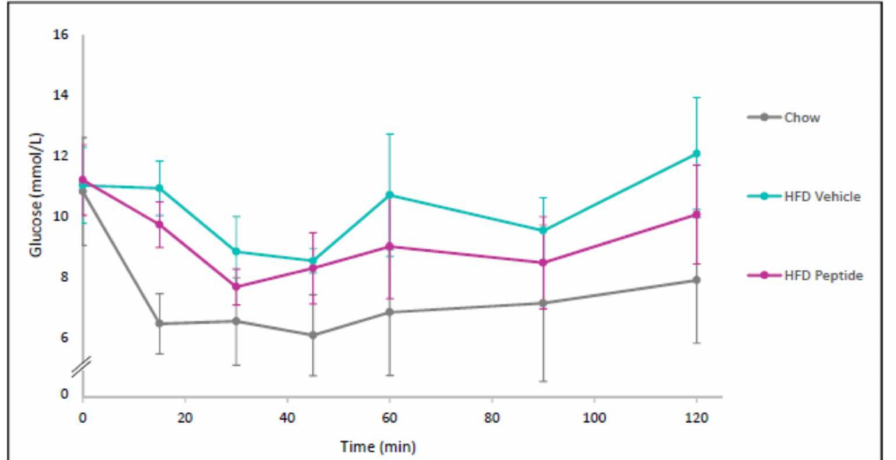
Figure 10. The TNFSF14 Peptide 7 reduces high fat diet-induced insulin resistance. Mice were placed on a chow or a high fat diet (HFD) ( n = 4–5 mice/group). The HFD was administered for 10 weeks before Vehicle or Peptide 7 therapy for 2 weeks. Mean ±